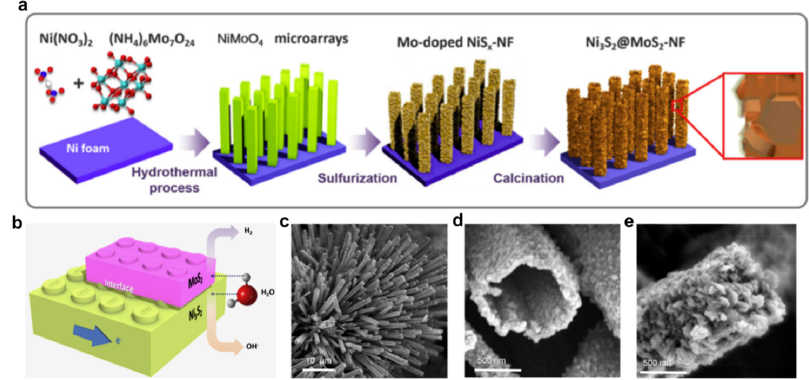
Figure 5. ( a ) Schematic illustration of the synthetic procedures for Ni3S2@MoS2eNF heterostructure. ( b ) Schematic diagram of hybridization between MoS 2 and Ni 3 S 2 for HER. ( c–e ) SEM images of 3D Ni 3 S 2 @MoS 2 eNF composite with different magnification. Reprinted from [104], Copyright (2019), with permission from Elsevier.